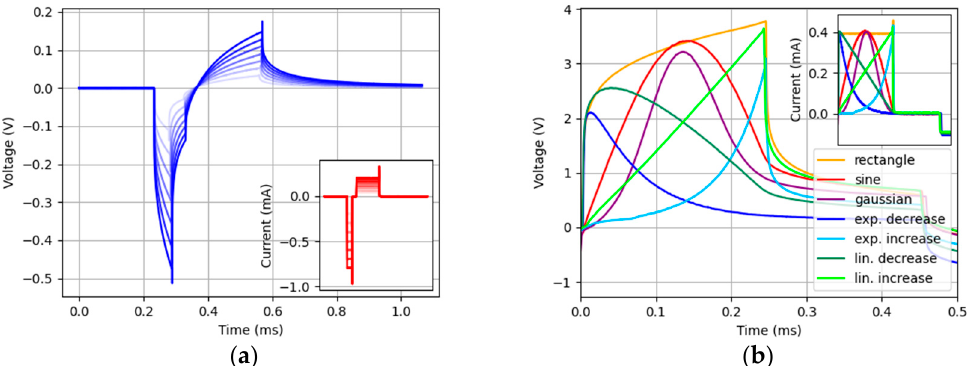
Figure 13. Stimulation waveforms as delivered on electrodes in a saline solution. Currents are recorded during the stim- ulation with a transimpedance amplifier; voltages are recorded on the electrode. ( a ) Typical DBS biphasic waveform ( Tc = 60 µs, inter-pulse of 60 µs, active balancing with a current ratio of 1:5), from Ic = 100 µA to 800 µA with a 100 µA step, performed on a DBS electrode. ( b ) Current stimulation pulse, with different shapes as performed in [20] for energy effi- ciency optimization. All waveforms have an amplitude of 400 µA, are balanced with a second negative constant current pulse and have been applied on a TIME electrode.